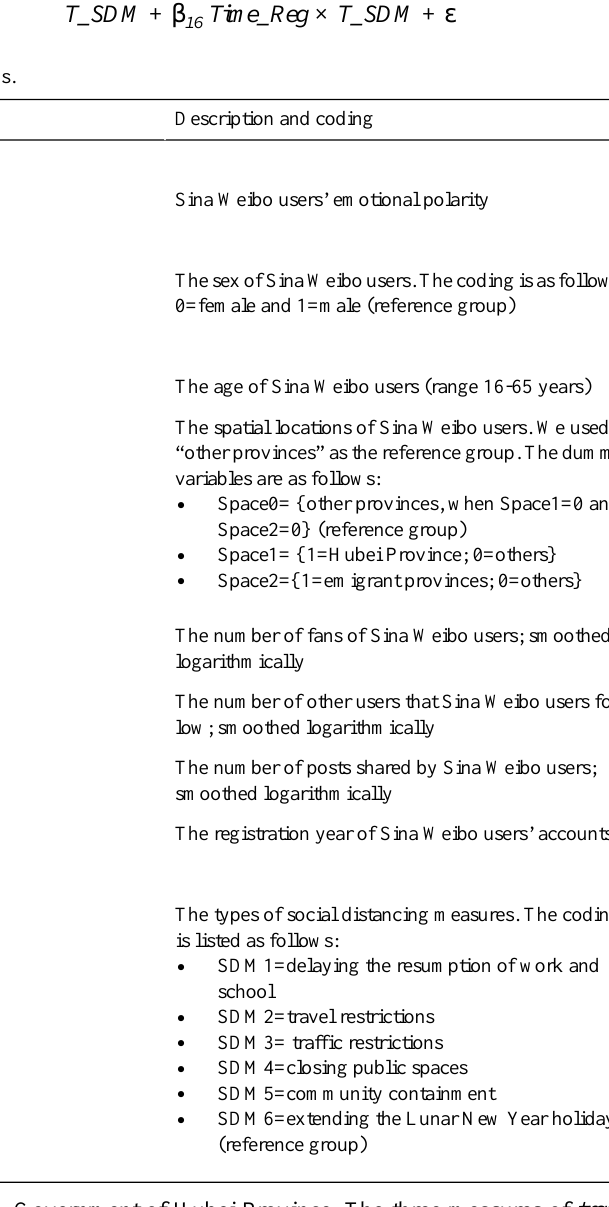
Table 3. Description of variables that influence Sina Weibo users’emotions.